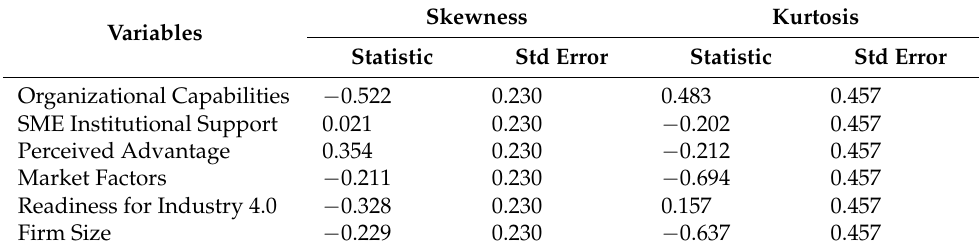
Table 12. Skewness and kurtosis values for the study variables.